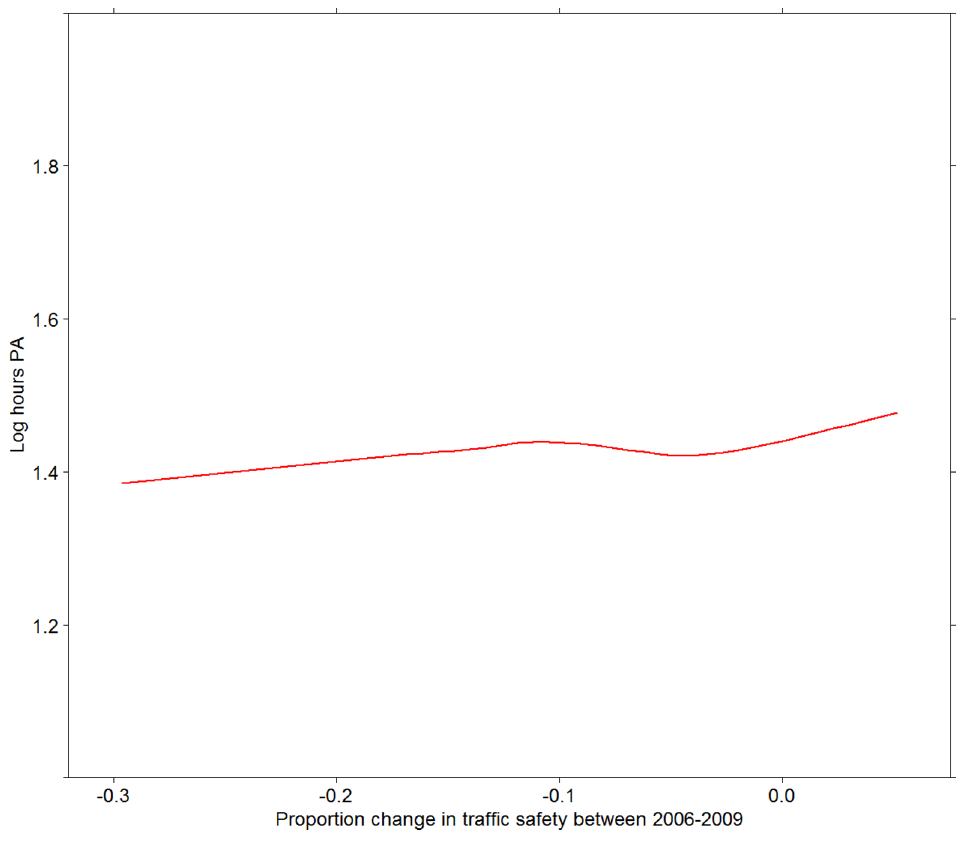
Figure 6. Frequency of PA in relation to change in traffic safety between 2006 and 2009. Frequency of PA is measured as log of hours of PA among those who are active. Relationship depicted by a Loess curve based on 1 degree of freedom.